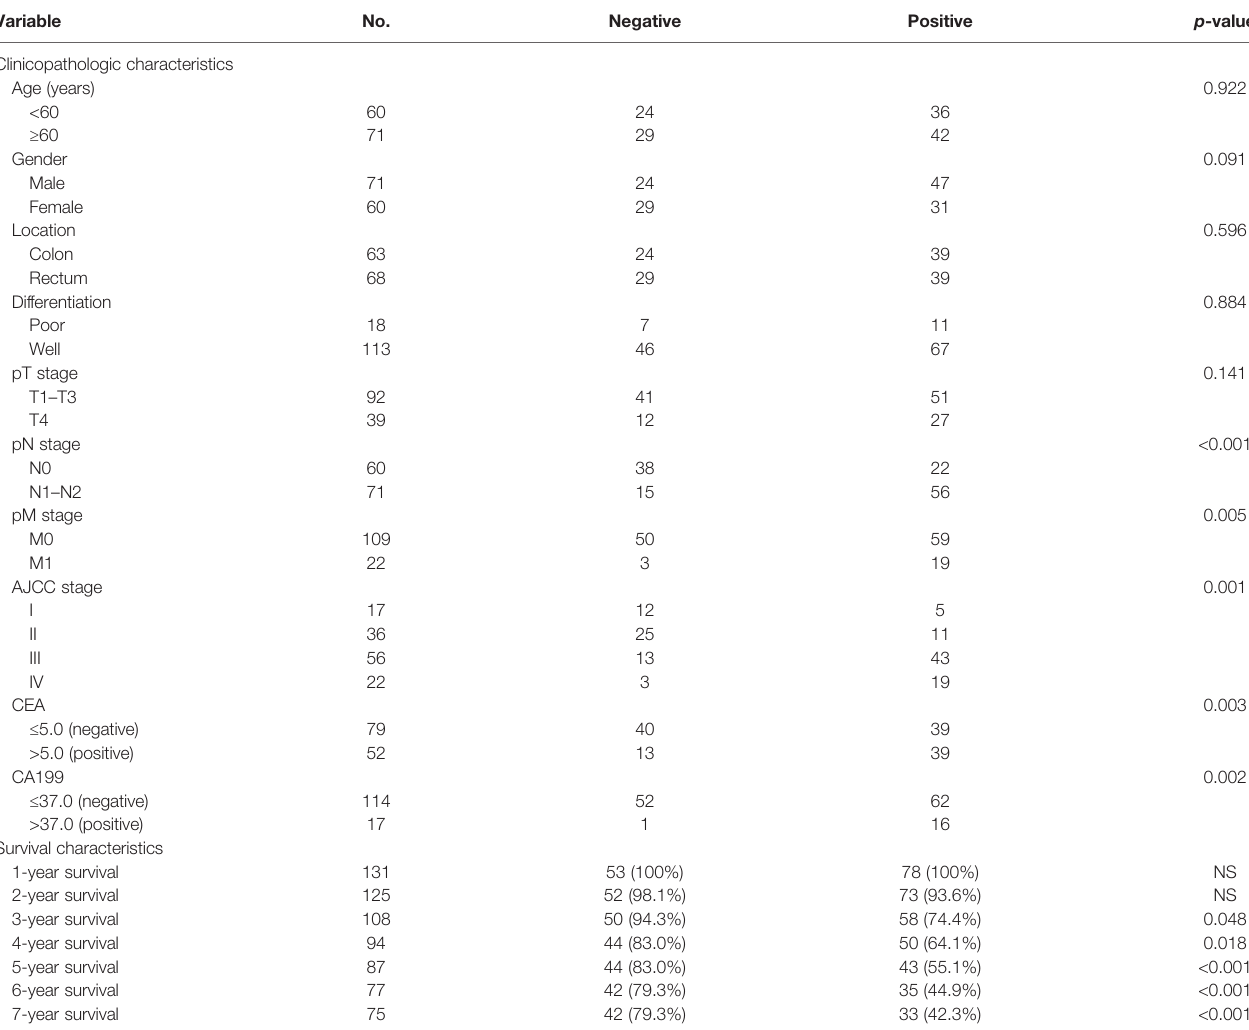
TABLE 2 | EVA1B staining expression associations with clinicopathologic and survival characteristics in CRC patients. Variable No. Negative Clinicopathologic characteristics Age